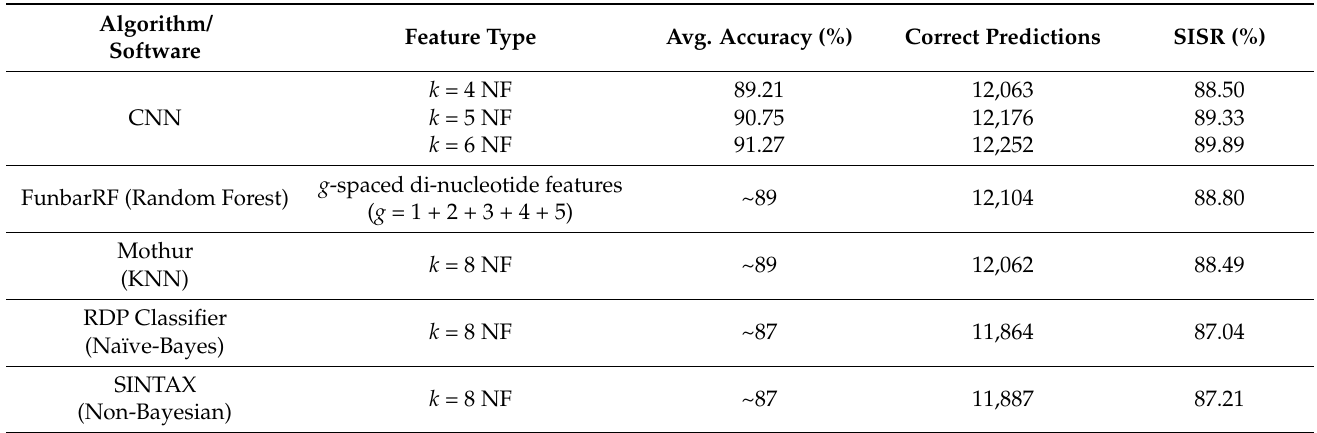
Table 10. Comparison among CNN model and other fungal ITS sequence classification software based on average accuracy (%) and SISR (%) values at the species level. Highest values of average accuracy (%), number of correct predictions and SISR (%) score are highlighted in